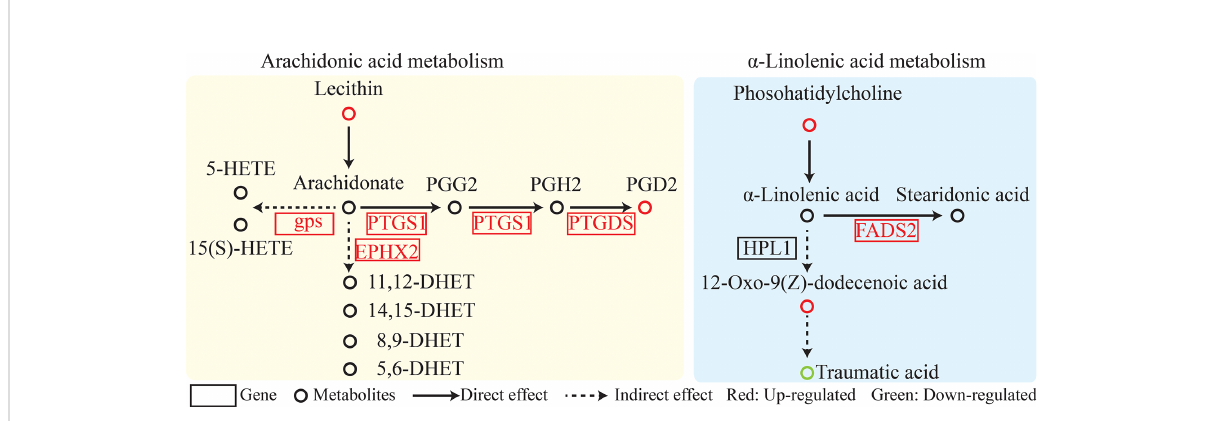
FIGURE 3 Linoleic acid metabolism and arachidonic acid metabolism pathway analysis.